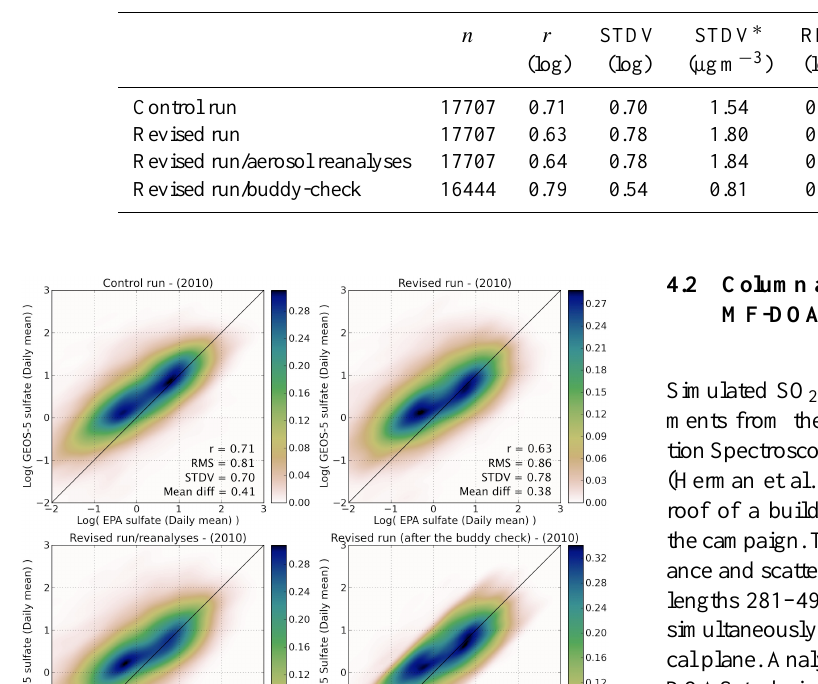
winter maximum for both the control run in red and the re- vised run in black, as stated in Sect. 2, the oxidation rates and the PBL dynamics are responsible for this seasonal